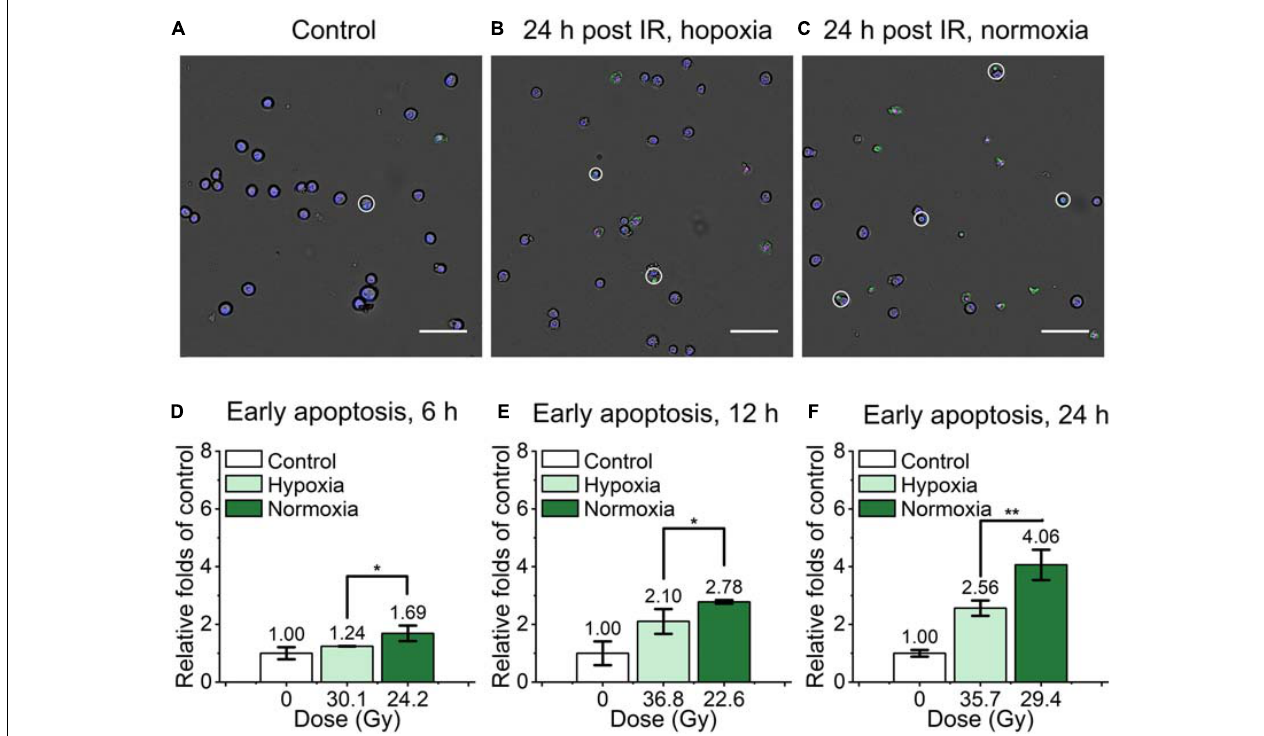
FIGURE 3 | Early apoptosis of irradiated normal fibroblast cells after FLASH irradiation. (A–C) Representative images of control (A) , irradiated cells in hypoxic (B) and normoxic condition (C) at 24 h after radiation. Early apoptotic cells were marked with white circles. Scale bars: 100 µ m. (D–F) The relative increasement of early apoptosis in irradiated cells between hypoxia and normoxia at 6 h (D) , 12 h (E) and 24 h (F) after radiation.